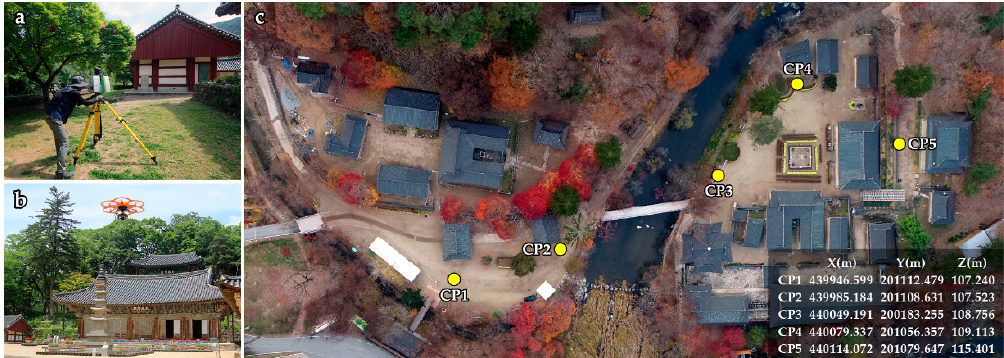
Figure 2. Equipment and methods used for 3D digital documentation: ( a ) terrestrial laser scanning using a specialized external camera; ( b ) hexacopter unmanned aerial vehicle (UAV); ( c ) five ground control points.